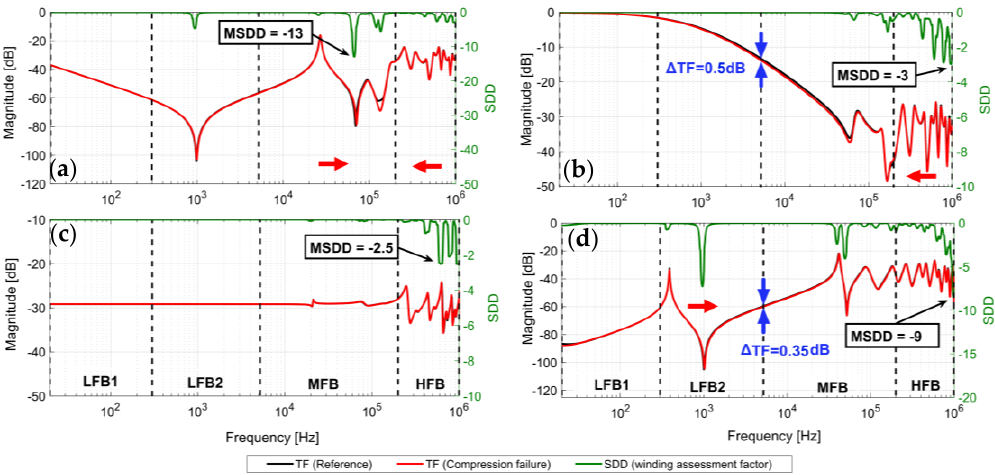
Figure 18. TFs of healthy and deformed (compression failure) B-phase LV winding (vector group YNyn0), SDD as a measure of deviation between TFs; ( a ) HV-OC, ( b ) HV-SC, ( c ) IIW, ( d ) CIW.